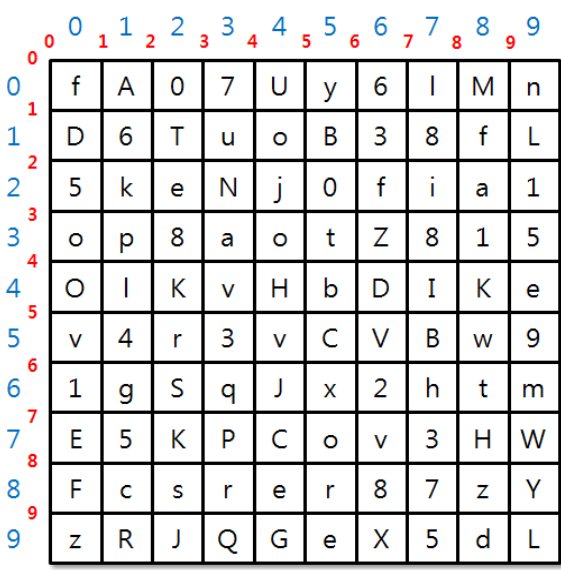
Figure 4. Keyset for Group Key